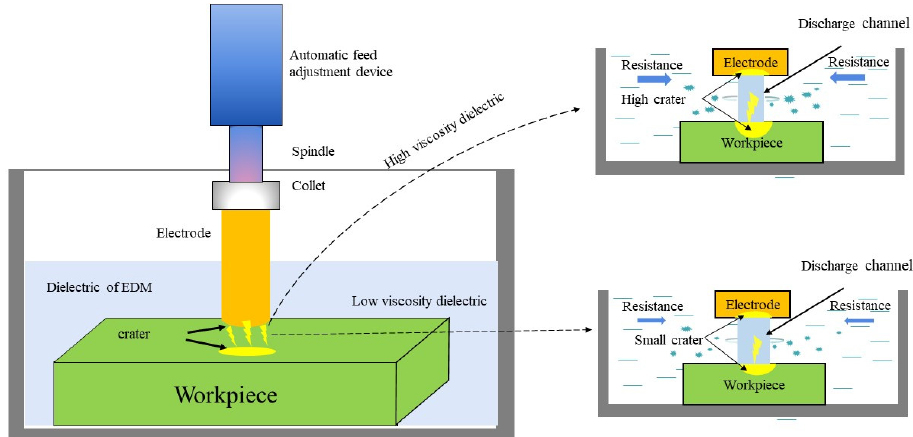
Figure 2. The influence of current, duty ratio, pulse duration, electrode and dielectric on MRR.